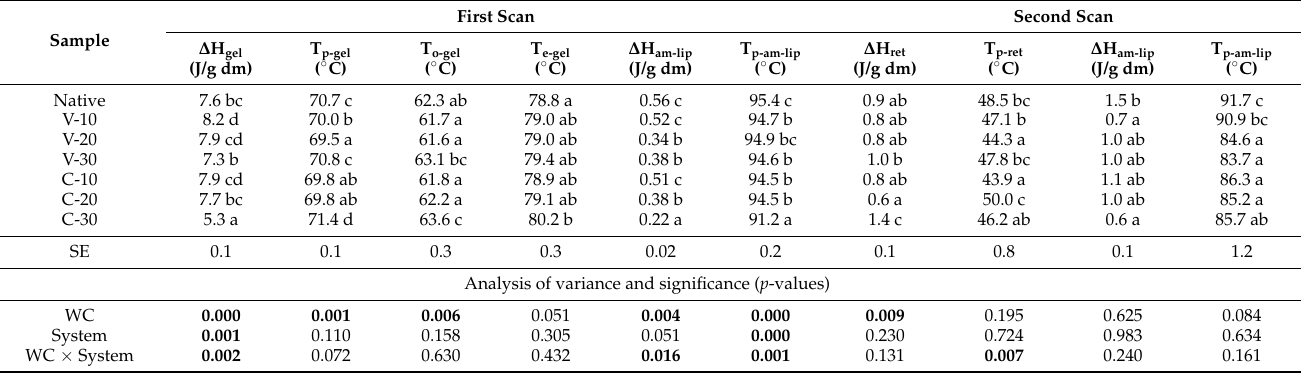
Table 5. Thermal properties of flour samples obtained from untreated (native) and microwave-treated quinoa grains.